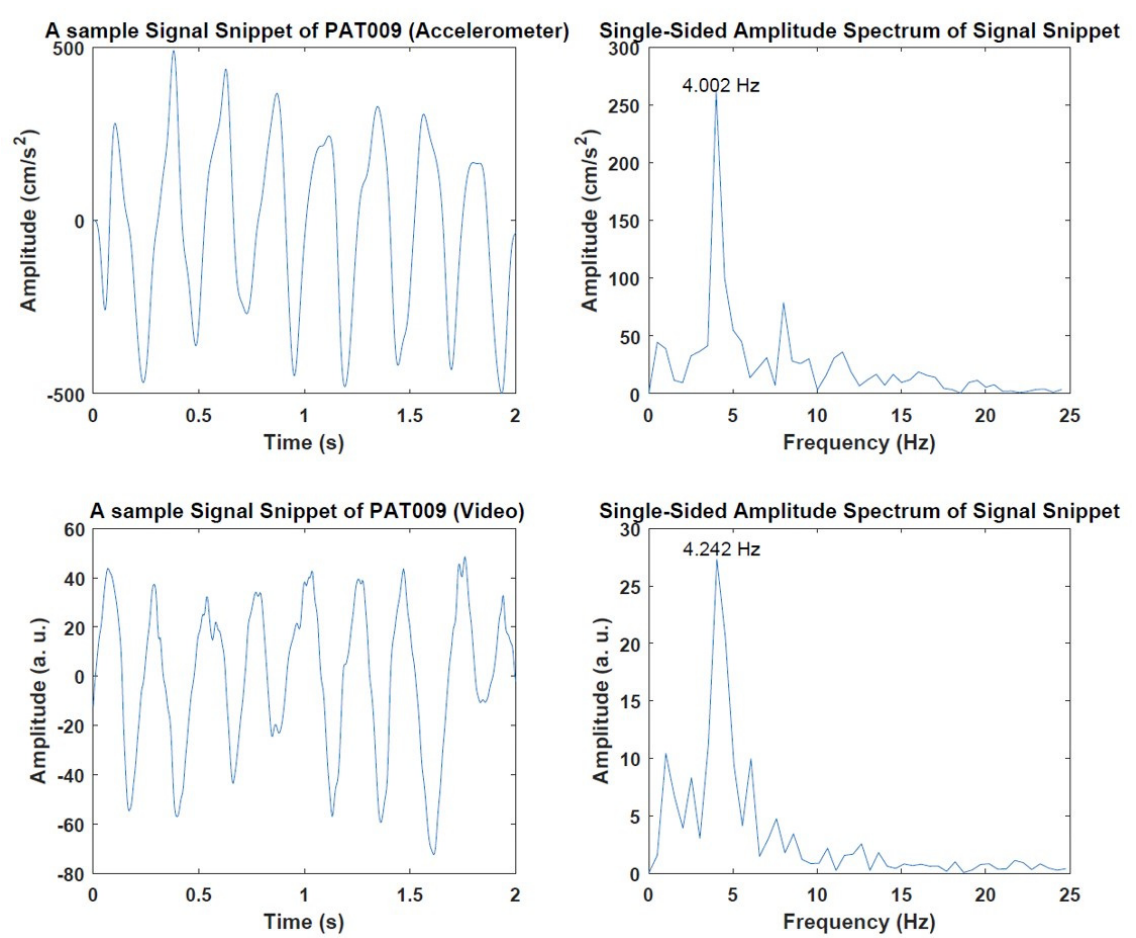
Figure 3. Example signals from PAT009. Accelerometer signal (top-left) and corresponding calculated frequency (top-right). Signal representation of wrist landmark (bottom-left) and corresponding estimated frequency (bottom-right).